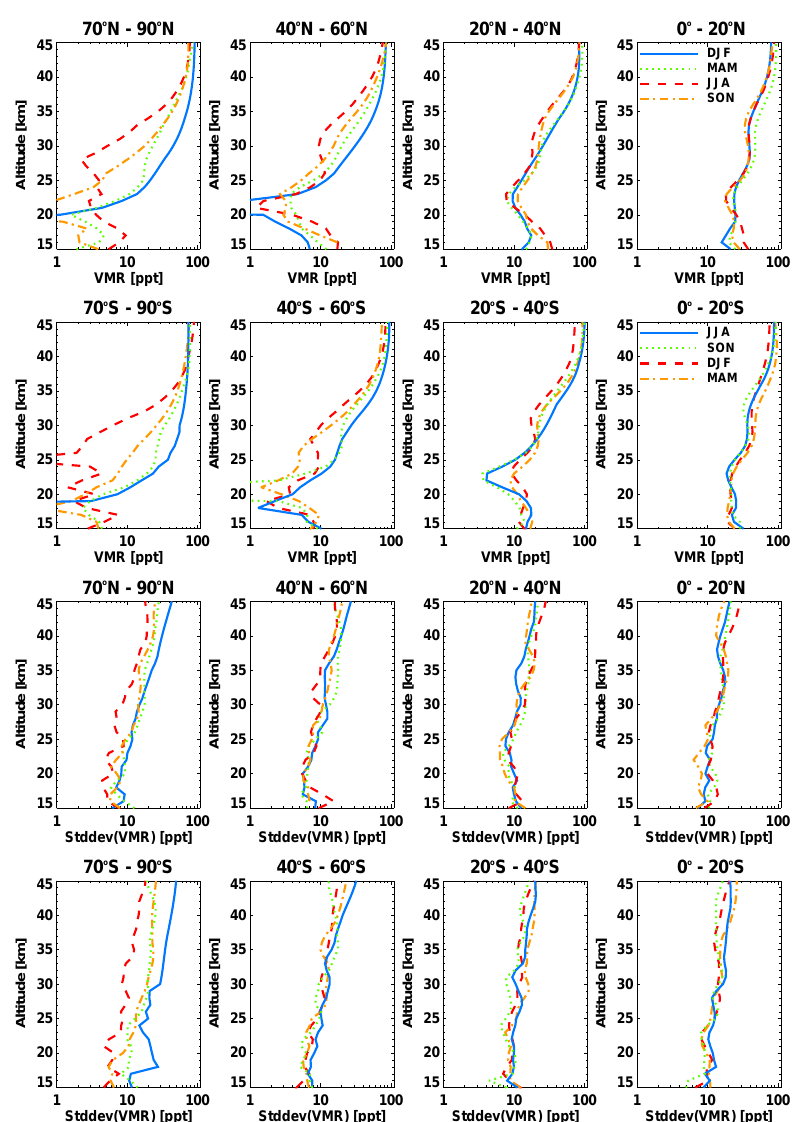
Fig. 8. Mean background seasonal profiles of SO 2 (top two rows) and standard deviation of the distribution (bottom two rows). The legend indicating the seasons in the top row refers to the Northern Hemisphere; the legend in the second row is valid for the Southern Hemisphere. The same periods of major volcanic influence as listed in caption of Fig. 7 have been